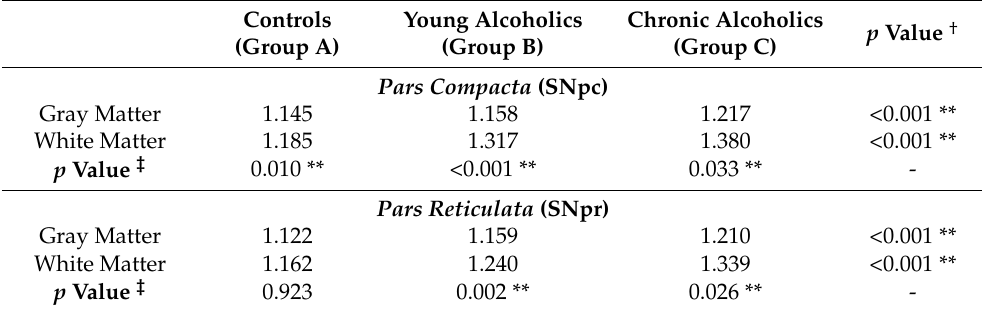
Table 7. Inter-group and intra-group comparisons of the differences in the grades of thickness based on the expression of fibronectin in the BM of the microvessels in the SN region (shown by weighted